Question: Draft a figure caption describing what is shown.
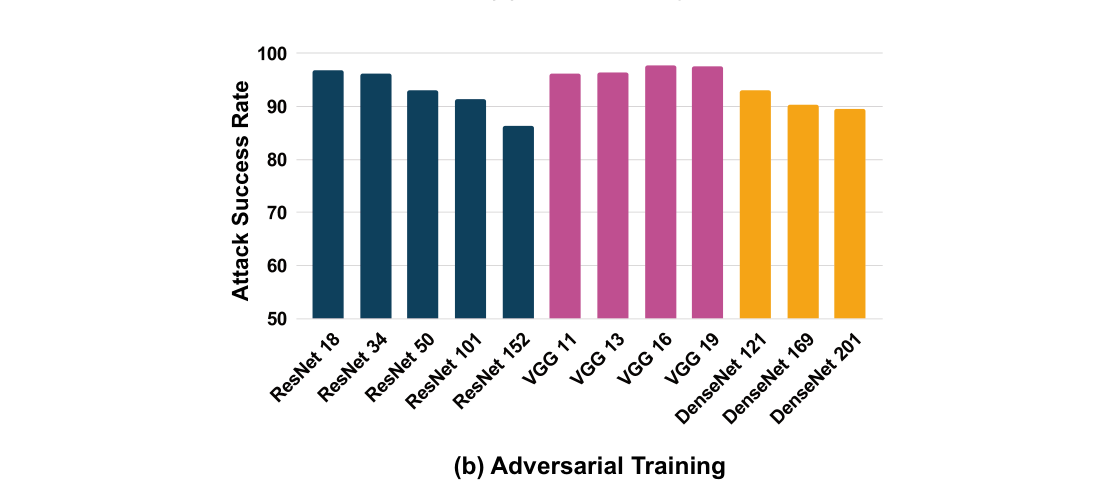
Answer: Bit Squeezing defense and Adversarial Training against SimBA on ImageNet. The model becomes easier to defend as the number of layers on the same model increases